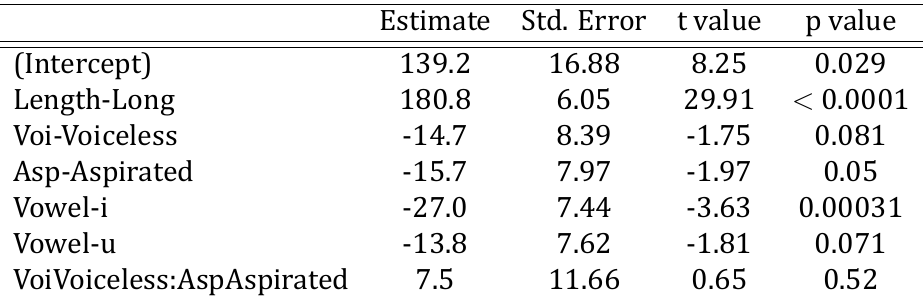
Table 4: Mixed effects model for phonological predictors of Telugu vowel duration. In- tercept: Length = Short; Voicing = Voiced; Aspiration = Unaspirated; Vowel =